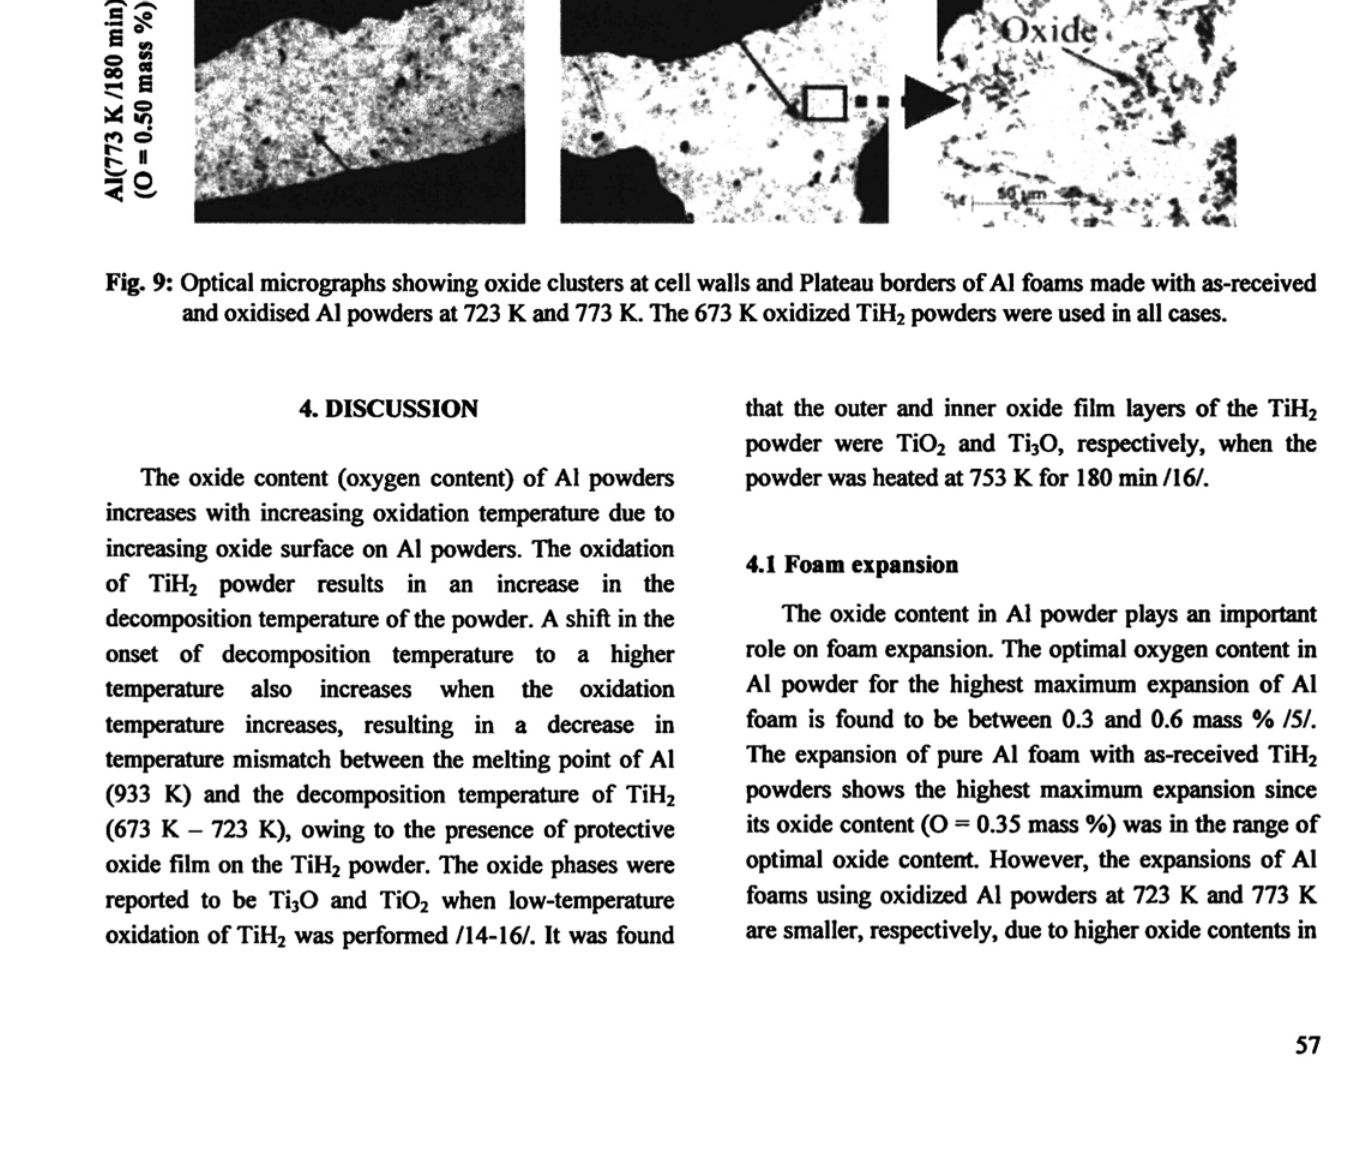
Fig. 9: Optical micrographs showing oxide clusters at cell walls and Plateau borders of Al foams made with as-received and oxidised Al powders at 723 K and 773 K. The 673 K oxidized Til I